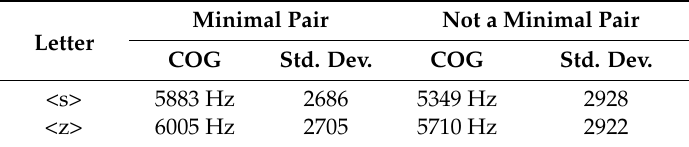
Table 8. Mean COG values in Hz and standard deviations by letter and status as a minimal pair or not.